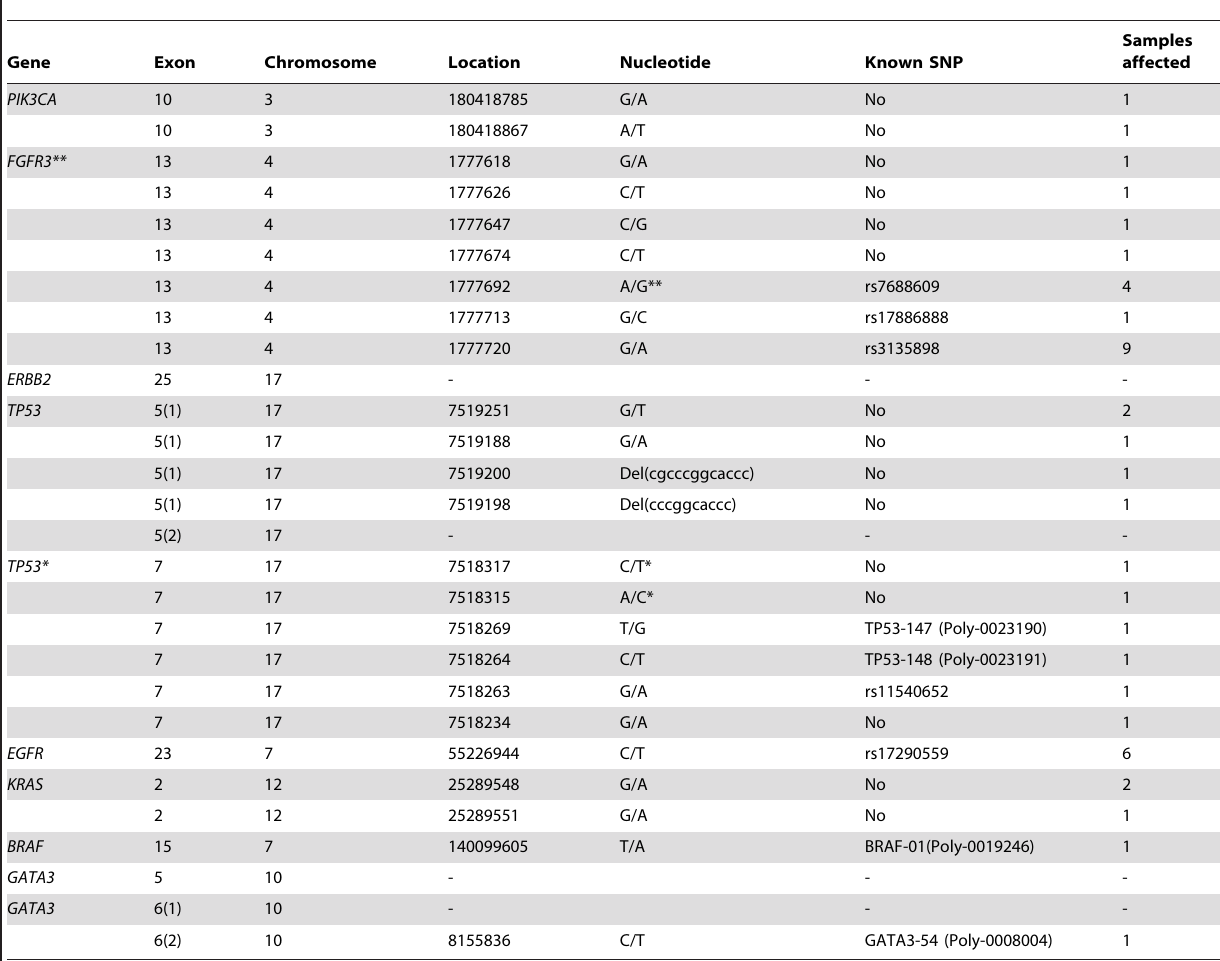
Table 4. Mutation details from the sequencing analysis of frozen samples.